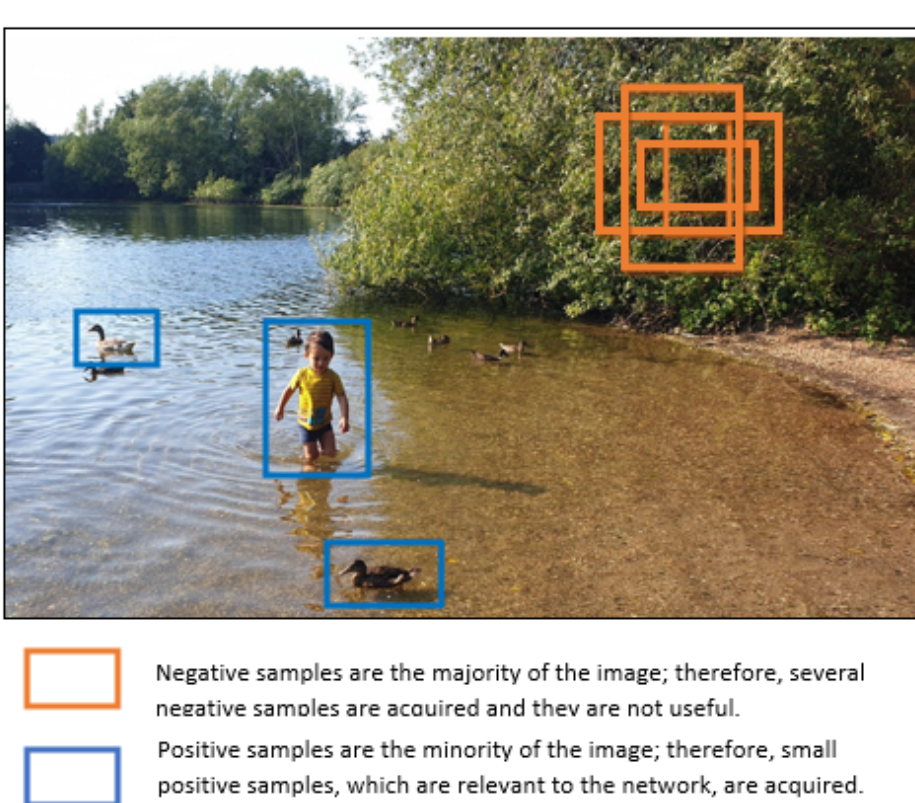
Figure 12. Foreground–background imbalance example, there are more negative (orange boxes) than positive (blue boxes)